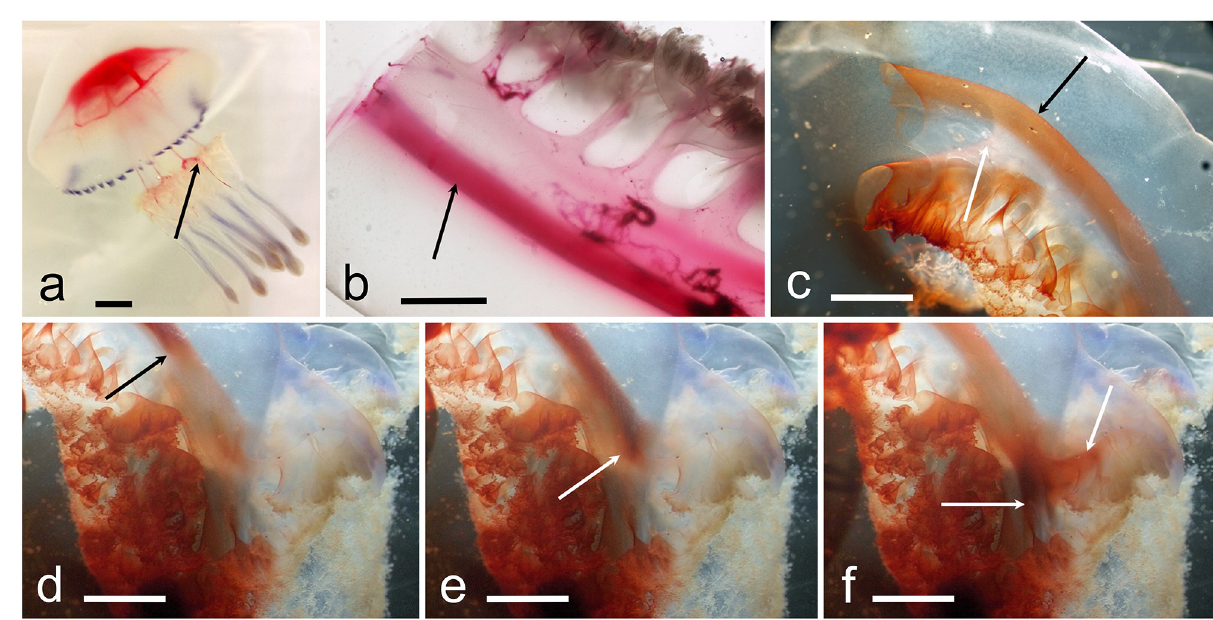
Fig 10. Functional anatomy of the gastrovascular system. (a) Living specimen as in Fig 9a and 9b, with mucous stained filament expelled from the upper openings of the external wings of the oral arms (scale bar = 1 cm). (b) Live excised scapula with red stain released just near the cutting surface (left). Stain mainly flowed in the lower hemi-canal (arrow) (scale bar = 0.5 cm). (c) Live oral arm cut under the scapulae, stained as above. Stain concentrated in the outer hemi-canal (black arrow), whilst the inner hemi-canal is unstained (white arrow). The frillings of the inner wing are stained by the stain droplets initially released in the proximity of the upper cutting surface, then externally diffused (bottom left) (scale bar = 0.5 cm). (d-f) Photographs from a clip following the stain diffusion into the outer hemi-canal. Arrows indicate three successive moments of the stain flux (scale bar = 0.5